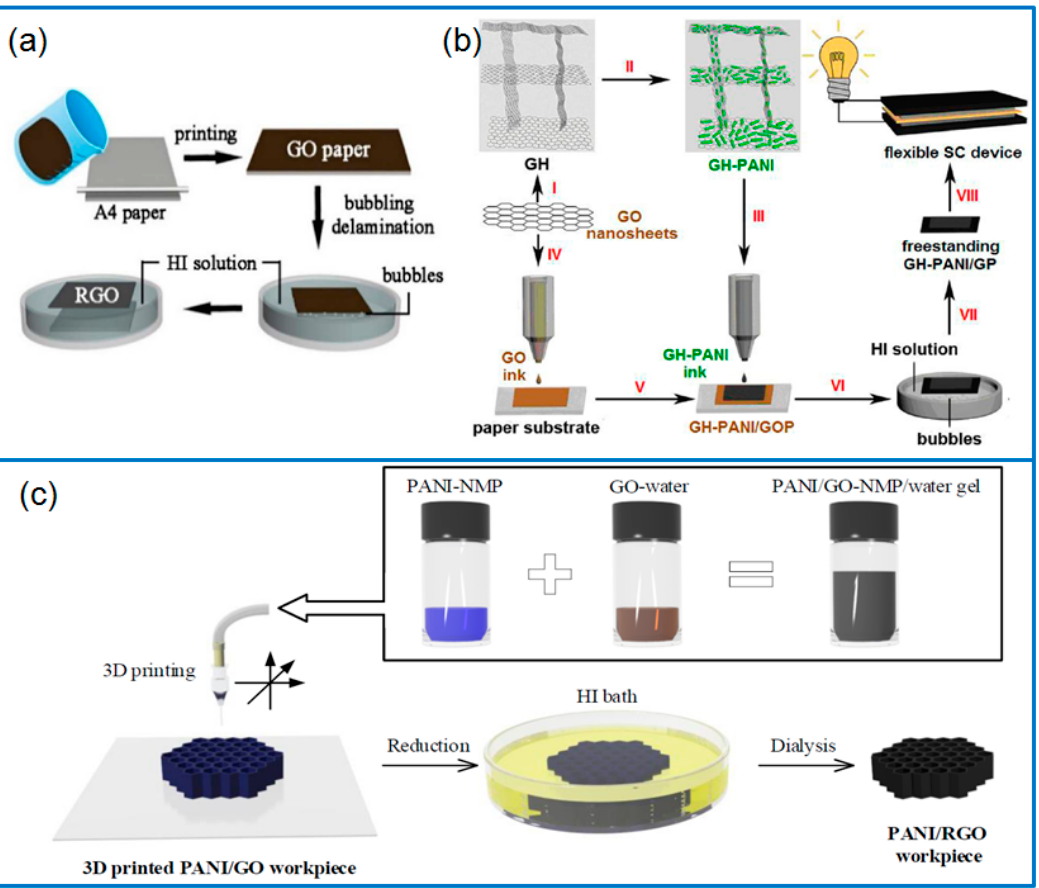
Figure 7. ( a ) Schematic for preparing a freestanding rGO paper; produced with permission [107].